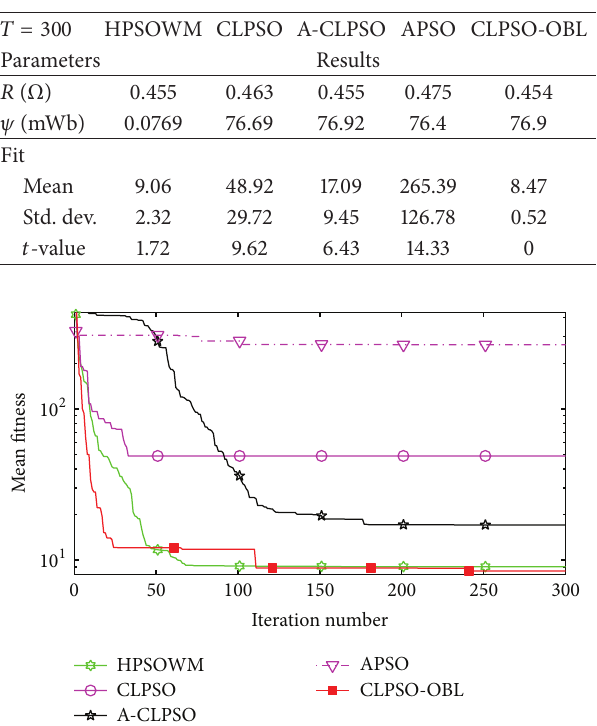
Table 2: Results of PMSM parameter identification with tempera- ture variation.